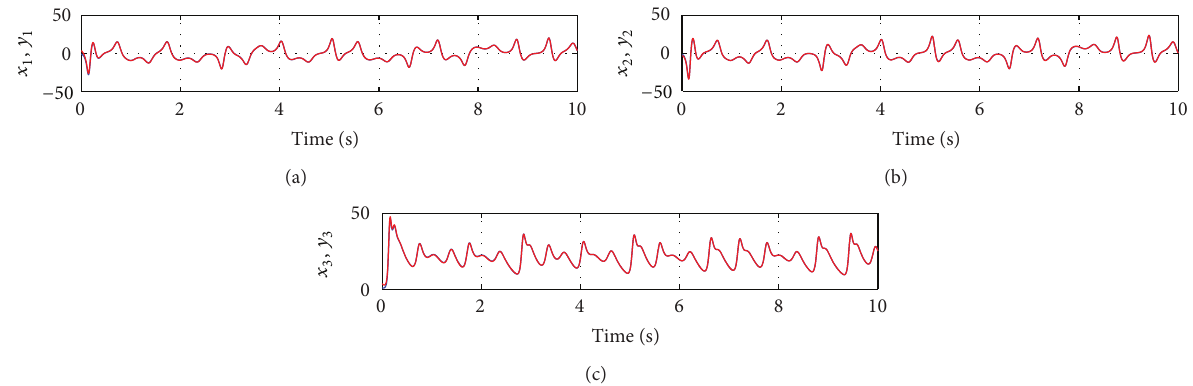
Figure 6: Synchronization of determined fractional-order unified chaotic system with 𝛼 = 1 (blue line represents the trajectories of the drive system, while red line represents the trajectories of the response system).